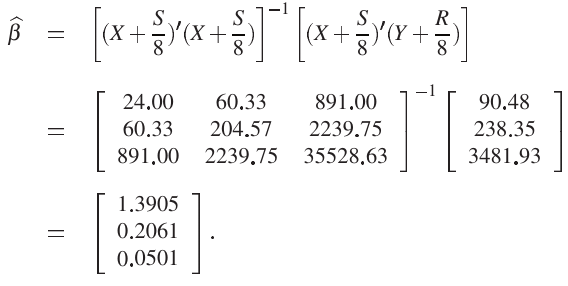
Table 1. Somemeasured colorcharacteristicsinExample 2. i